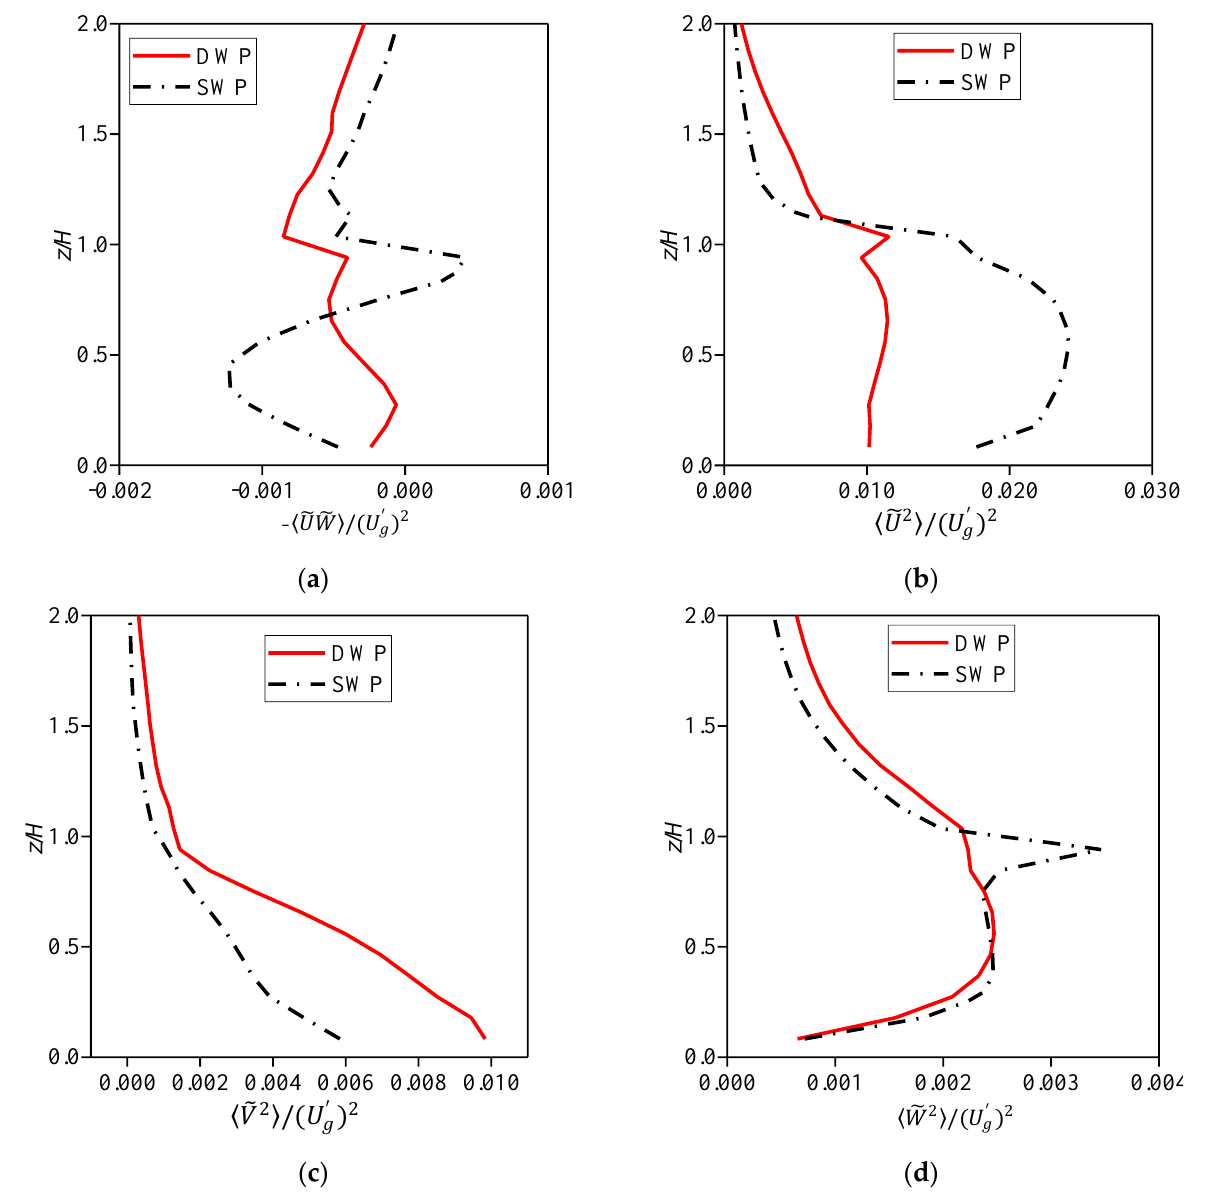
wake of buildings of DWP, which can be seen in Figure 14.